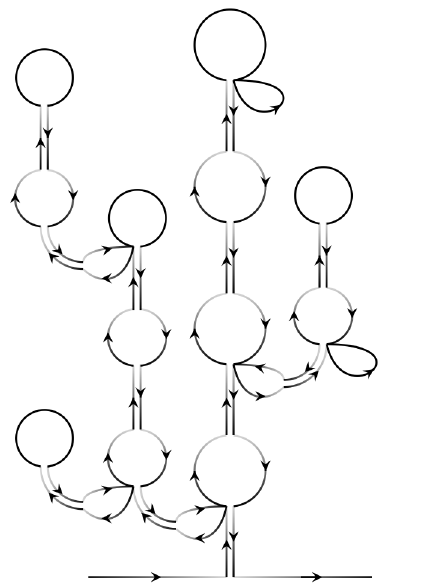
Figure 3: A generic O ( 1 ) cactus, including both 3-pt ( ˜ Wh 2 ) and 5-pt ( ˜ Wh 4 ) ver- tices. Here we have a combined factor of 1 / N 12 from the vertices, which is precisely cancelled by the factor of N 12 from neurons running in the internal loops. In this particular diagram, we have included two petals on the right-hand side of the cac- tus (the internal c propagators that begin and end at the same vertices), and four 0 branches (self-similar cacti whose would-be external legs form a loop at the vertex where the child branch joins the